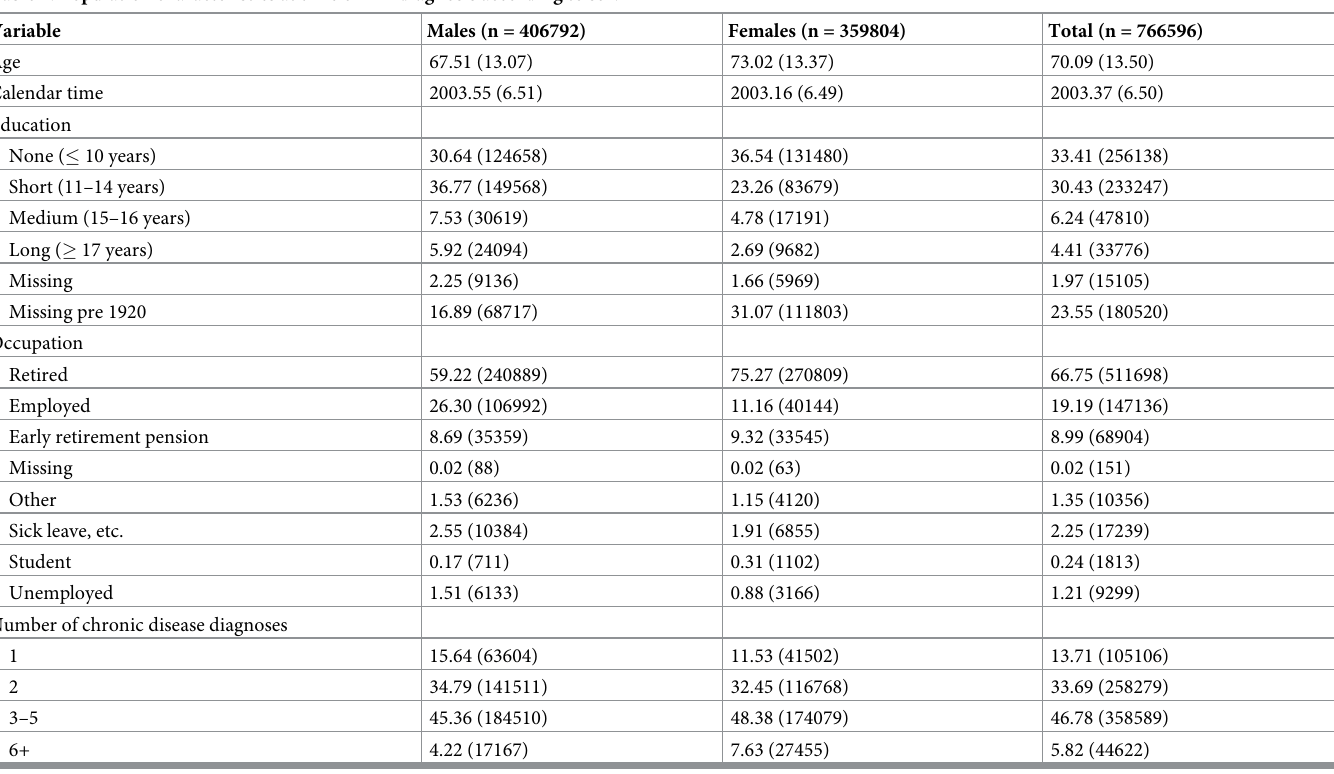
Table 2. Population characteristics at time of HD diagnosis according to